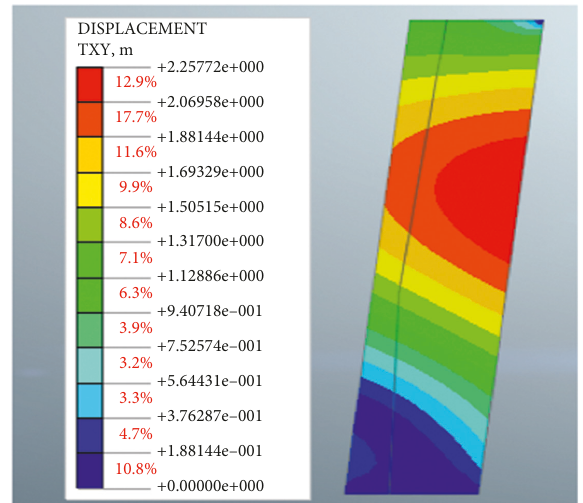
Figure 6: Comparison with different stress variation curves with the x